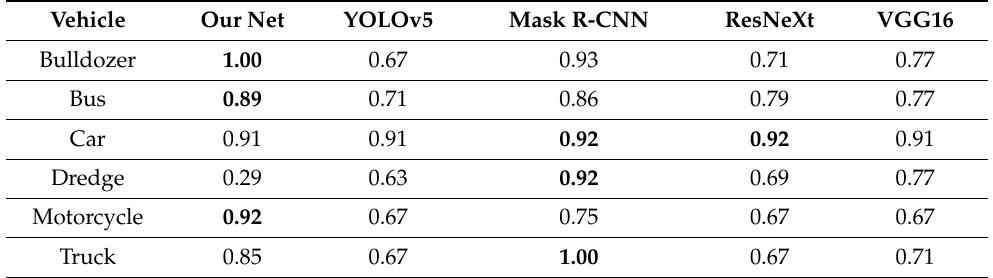
Table 2. Comparison of recall scores for each class. The best indicators for each class are highlighted in bold.